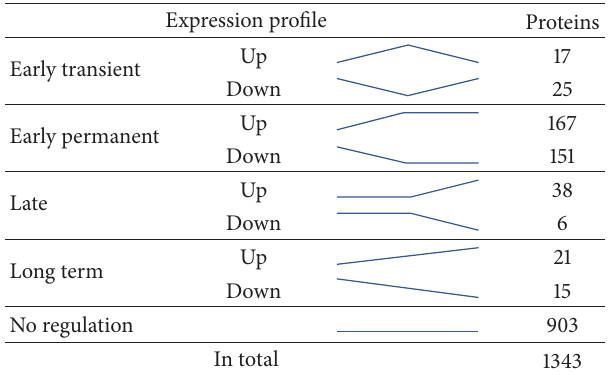
Table 1: Number of proteins with expression profiles from day 0 to day 7. Discrimination between early, late, and long-term changes as well as between transient and permanent regulations shows that most significant changes occur early and remain regulated